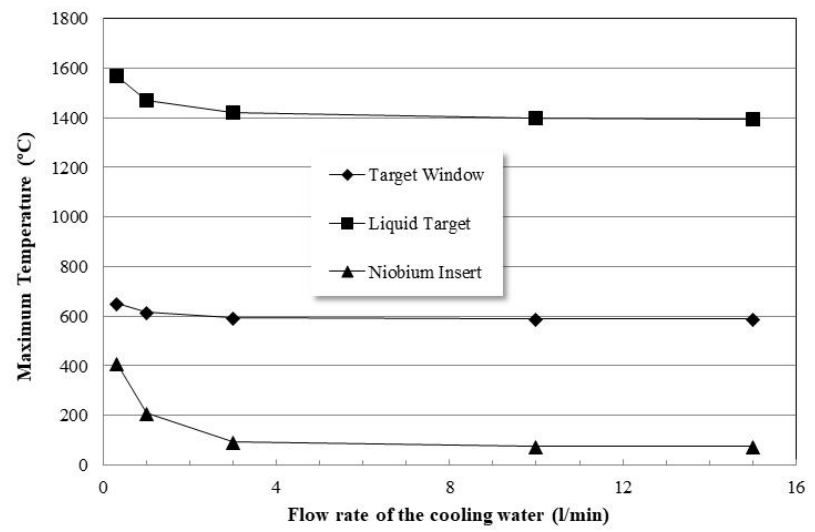
Figure 14. Maximum temperatures of the target window, liquid target and niobium insert as a function of the flow rate of the cooling water.